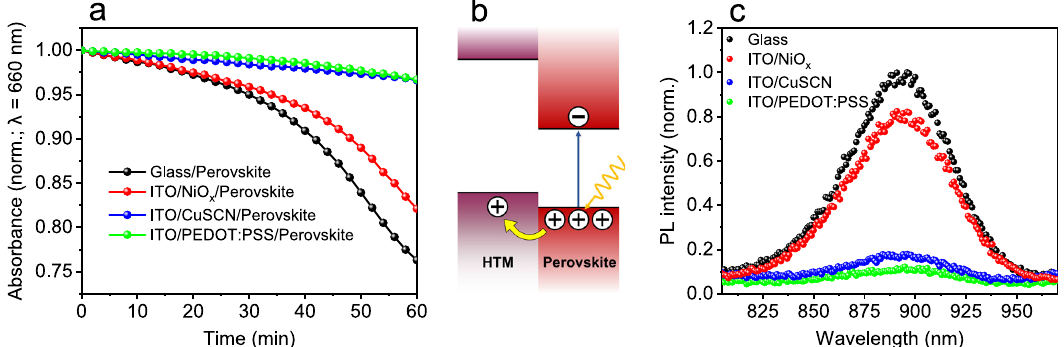
Fig. 6 Effect of bottom hole transport layers on Sn perovskite stability. a Time evolution of relative absorbance at 660 nm of perovskite thin fi lms deposited on glass and ITO/HTM substrates and exposed to ambient conditions (23 °C, 38% RH). b Schematic illustrating hole withdrawal from the perovskite via charge transfer to the HTM layer. c Steady-state PL spectra of perovskite thin fi lms deposited on glass and ITO/HTM substrates (shown in legend). From these data, we estimate the yields of PL quenching to be 18% (ITO/NiO x /(PEA) 0.2 (FA) 0.8 SnI 3 ), 82% (ITO/CuSCN/(PEA) 0.2 (FA) 0.8 SnI 3 ) and 88% (ITO/PEDOT:PSS/(PEA) 0.2 (FA) 0.8 SnI 3